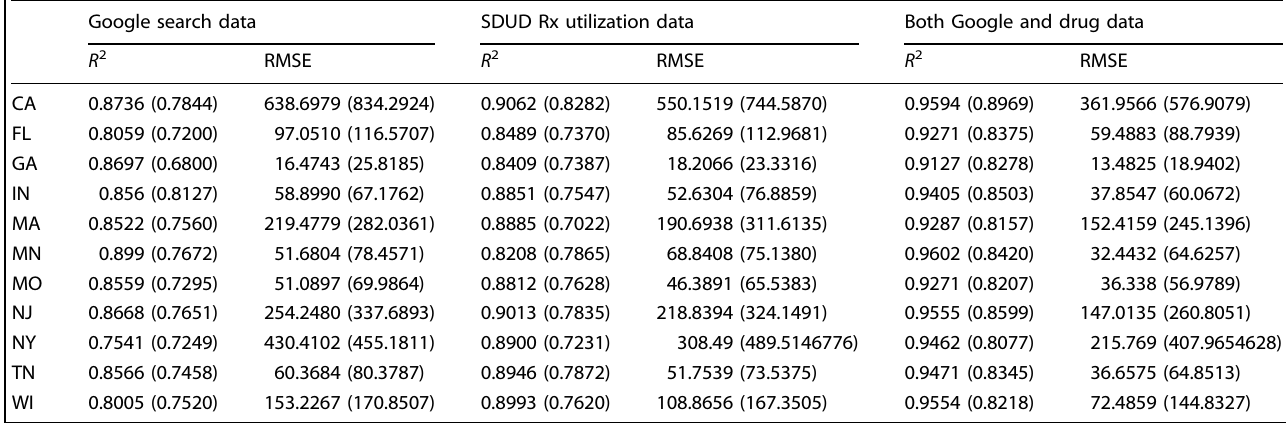
Table 1. One-quarter-ahead (and two quarter-ahead) prediction accuracy of different models across states, 2005 – 2015. Google search